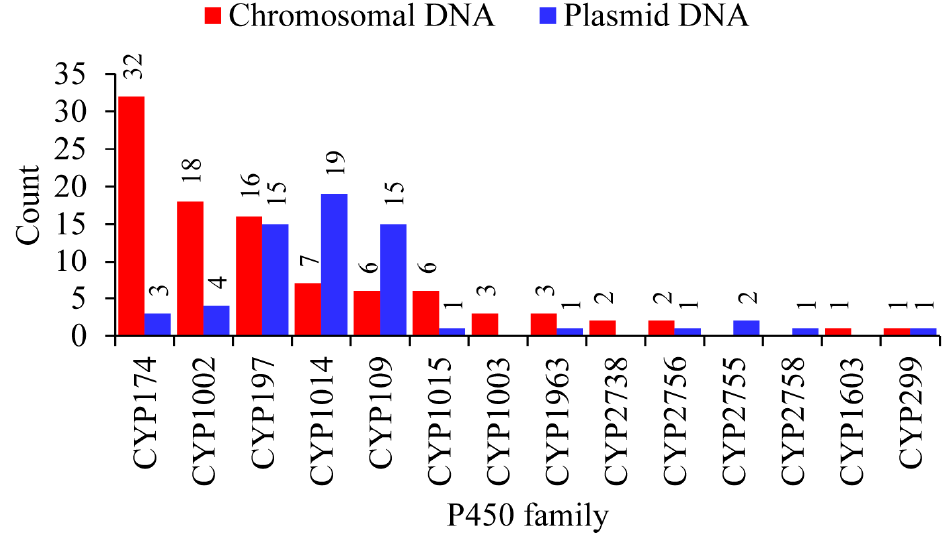
Figure 4. Comparative analysis of P450 families between chromosomal and plasmid DNA from 40 archaeal species. The numbers next to the bars represent the member count for that family. Detailed information is provided in Tables S5 and S6.